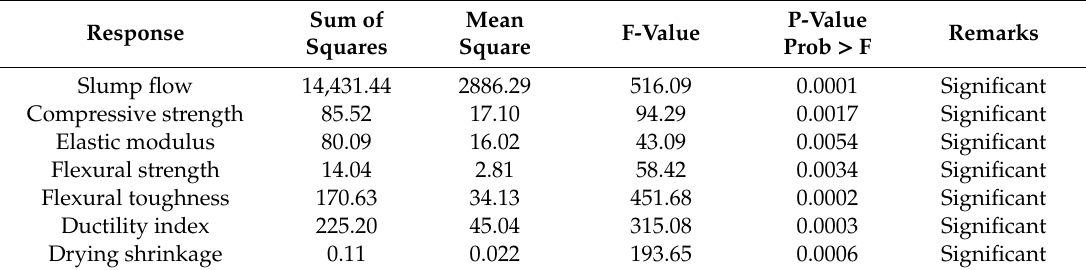
Table 9. ANOVA results for the full regression model of each